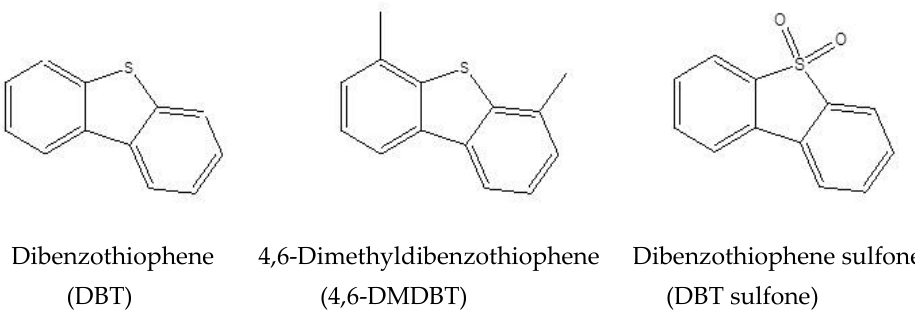
Figure 1. Chemical structures of the studied thiophenic compounds: dibenzothiophene (DBT), 4,6- dimethyl-dibenzothiophene (4,6-DMDBT), and dibenzothiophene sulfone.